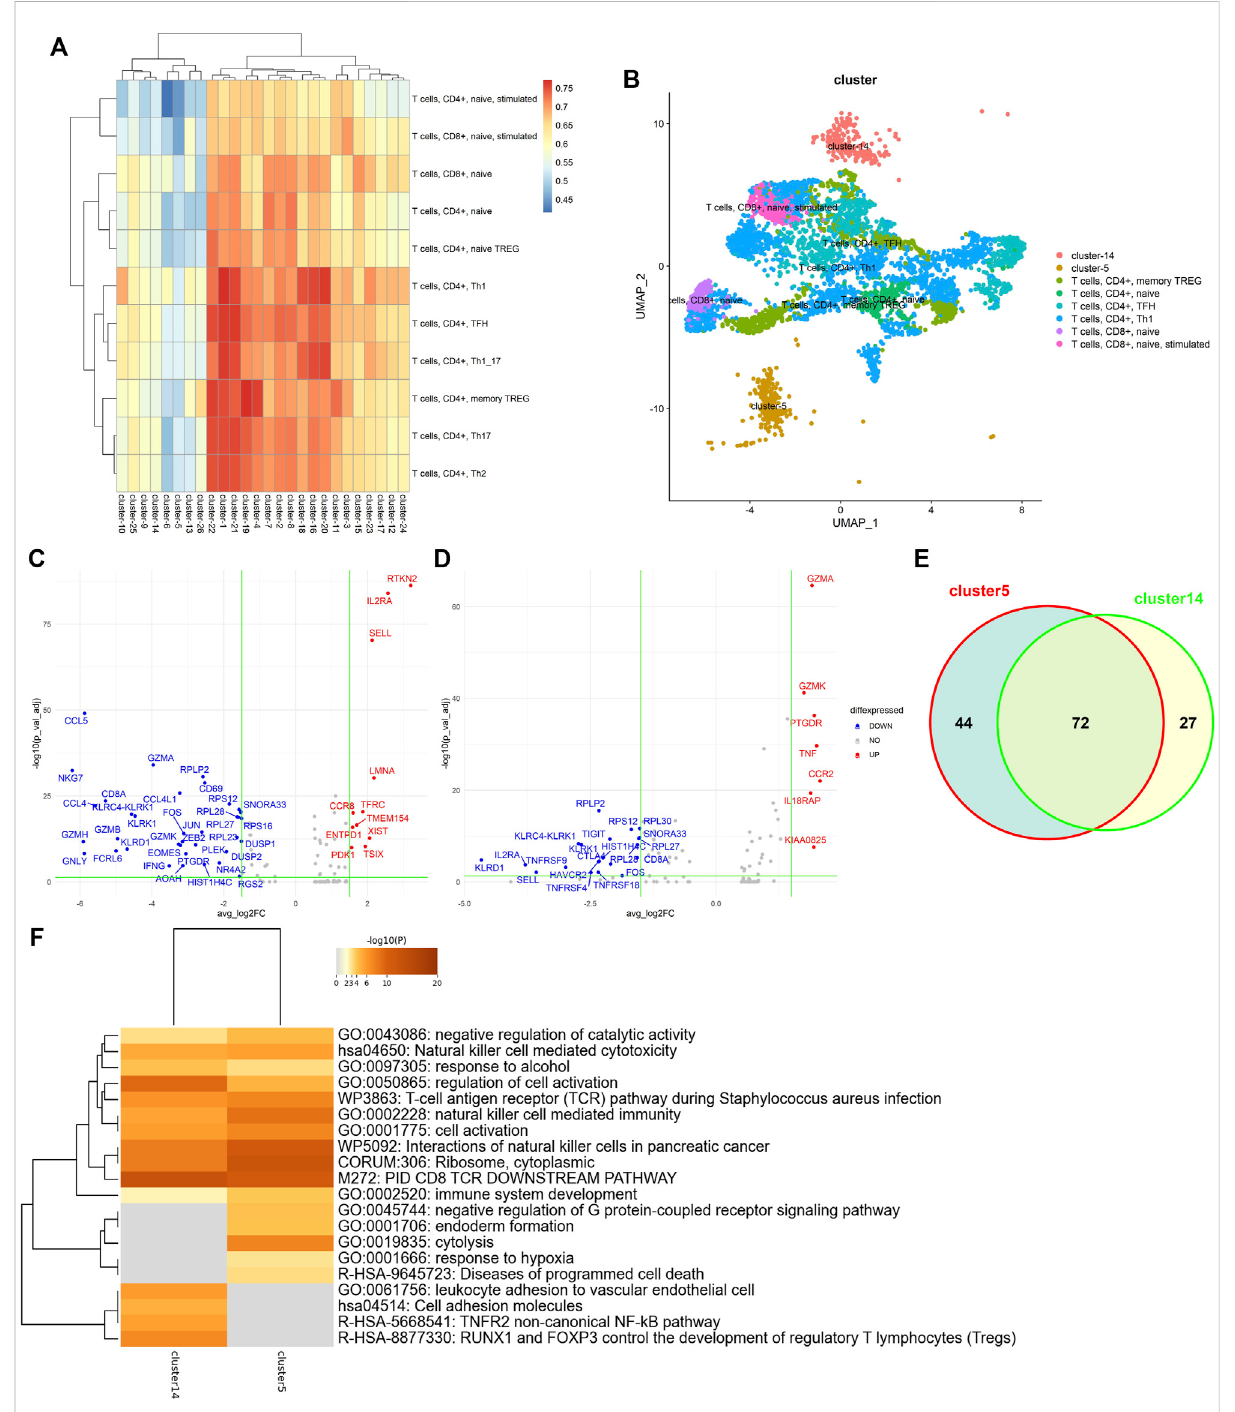
FIGURE 7 Single-cell transcriptional pro fi ling of the tumor-in fi ltrating lymphocytes. (A) Heatmap of Pearson coef fi cient values between 26 clusters and 11 T-cell subtypes; (B) t-SNE plots of tumor-in fi ltrating lymphocytes annotated by LFSC using the ImmGen database as the reference; (C) volcano plot showing differentially expressed genes in cluster 5; (D) volcano plot showing differentially expressed genes in cluster 14; (E) Venn diagram showing the overlap of DEGs between cluster 5 and cluster 14; (F) heatmap of the enriched term across DEGs on cluster 5 and cluster